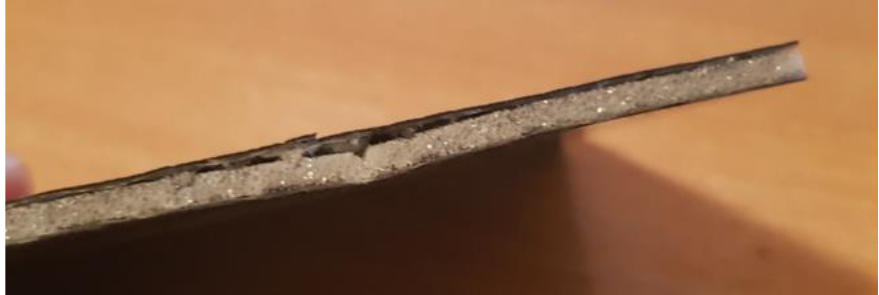
Figure 12. Separated core and face in the composite with Airex core.